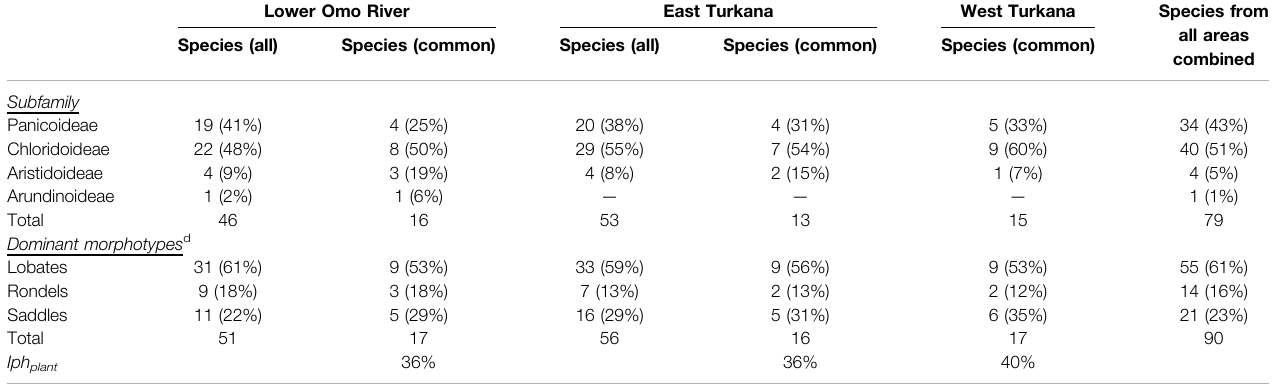
TABLE 2 | Grass subfamily occurrence based on Lower Omo River Valley a , East Turkana b and West Turkana c fl oristic studies, and potential dominant phytolith